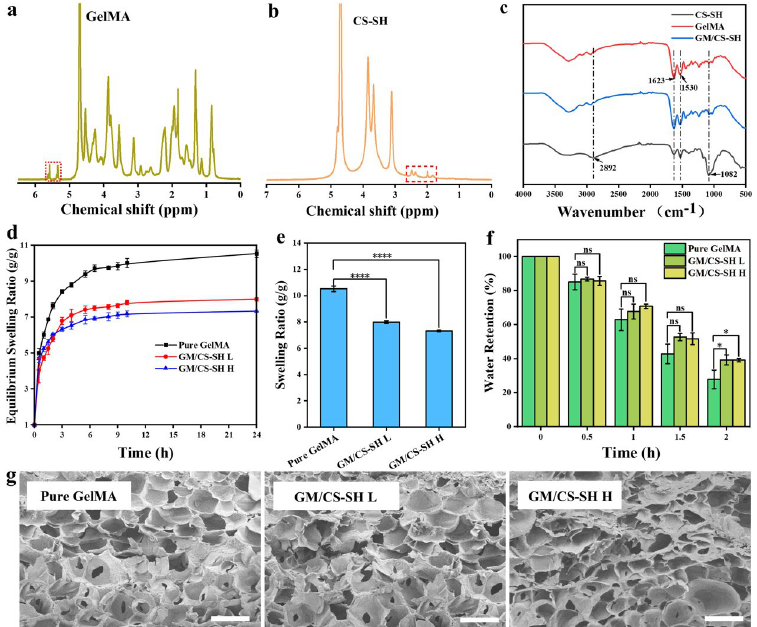
Figure 2. Characterization of GelMA, CS-SH, and GM/CS-SH hydrogel. 1 H-NMR of ( a ) GelMA and ( b ) CS-SH. ( c ) FTIR spectra of CS-SH, GelMA, and GM/CS-SH hydrogel. ( d ) Water absorption and ( e ) swelling ratio of pure GelMA, GM/CS-SH L, and GM/CS-SH H. ( f ) Water retention of GelMA, GM/CS-SH L, and GM/CS-SH H in the first two hours. ( g ) The SEM of hydrogels, scale bar: 200 μm. (Statistical significance was calculated via one-way ANOVA using Bonferroni’s post hoc test. ns: no statistical difference, * p < 0.05, **** p < 0.0001.) All data are presented as mean ± (pure GelMA), 6.12 ± 1.224 kPa (GM/CS-SH L), and 31.78 ± 3.315 kPa (GM/CS-SH H), re- spectively (Figure 3c). The improvement in the compressive modulus could have resulted